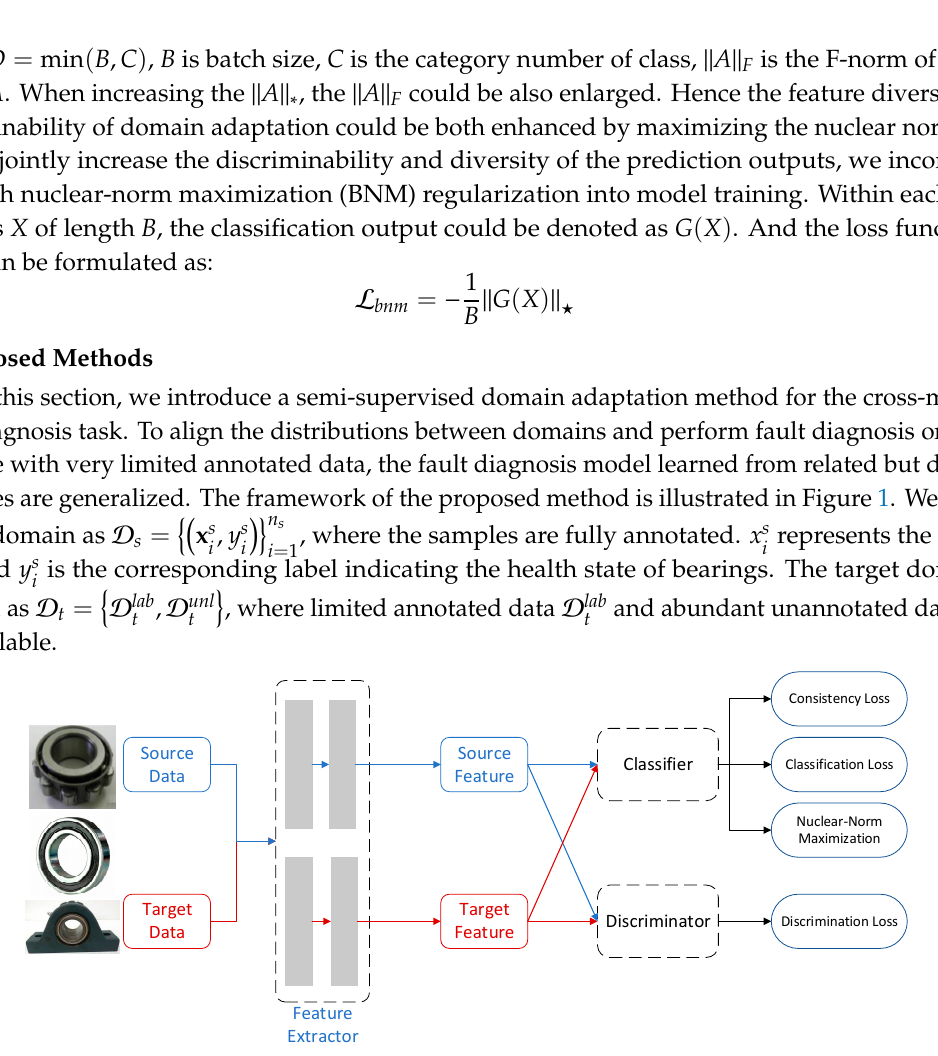
Figure 1. The architecture of adaptation the proposed method.